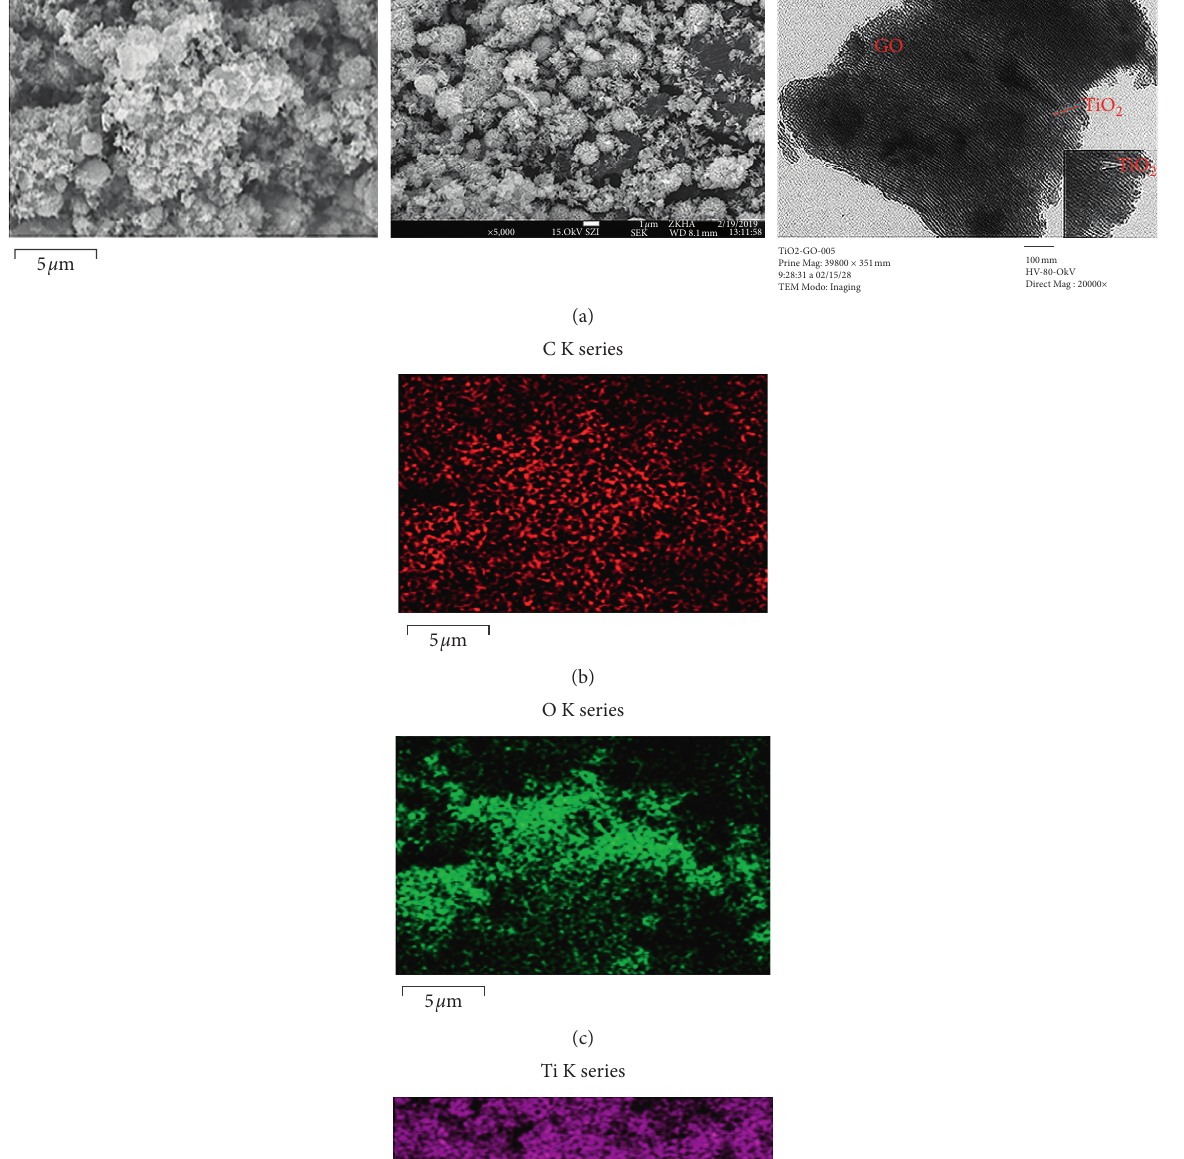
assembled GO-TiO on the membrane surface, so mem- 2 brane surface resistance could be increased, thus reducing the membrane flux.